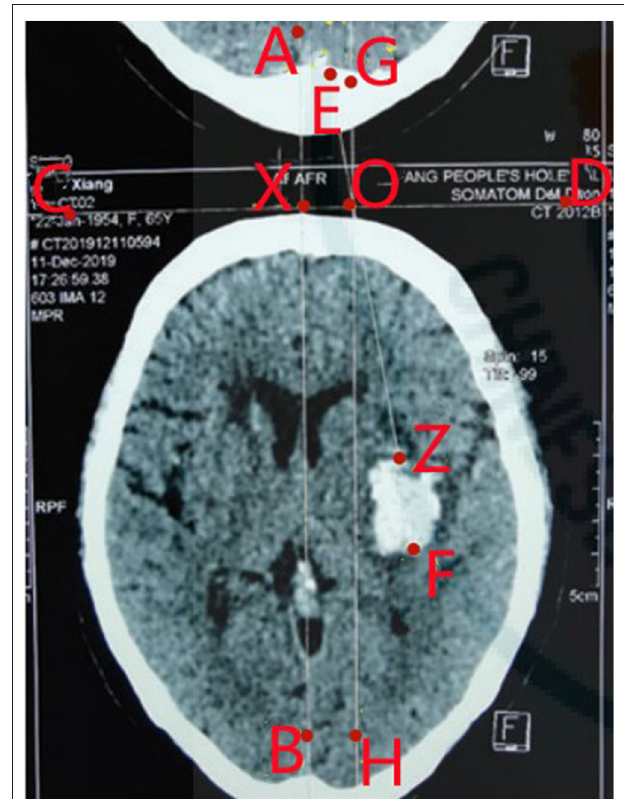
FIGURE 1 | The cerebral CT image. A: A point on the midline (vertical line) of the CT image; B: Another point on the midline of the CT image; C: A point on the vertical line (horizontal line) of the midline AB, the horizontal line is close to the scalp; D: The midline AB A point on the vertical line (horizontal line) of the puncture track; E: a point on the reverse extension of the puncture tract OF; F: The most distal end of the hematoma; G: A point on the vertical line GH, GH is perpendicular to the horizontal line CD, the vertical point is Point O; X: The intersection of the vertical line AB and the horizontal line CD; O: The puncture point, which is a point on the horizontal line CD, and the line segment XO is 1.5cm; Z: The intersection of the puncture tract OF and the